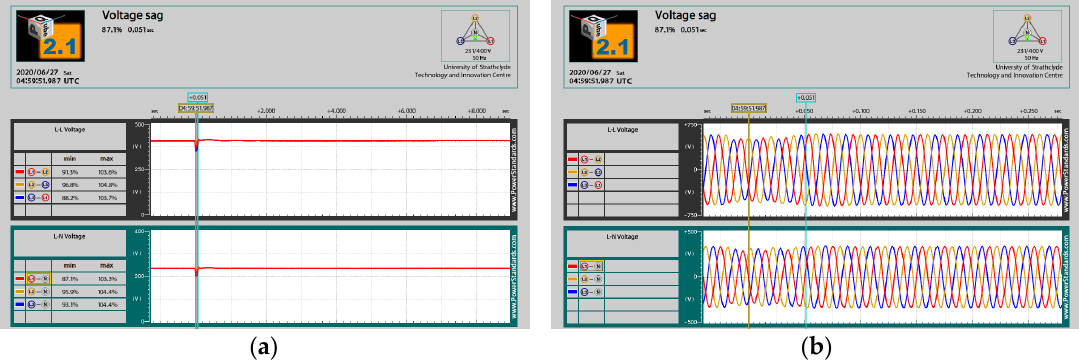
Figure 24. An actual voltage sag recorded by PQube at the University of Strathclyde on 27 June 2020